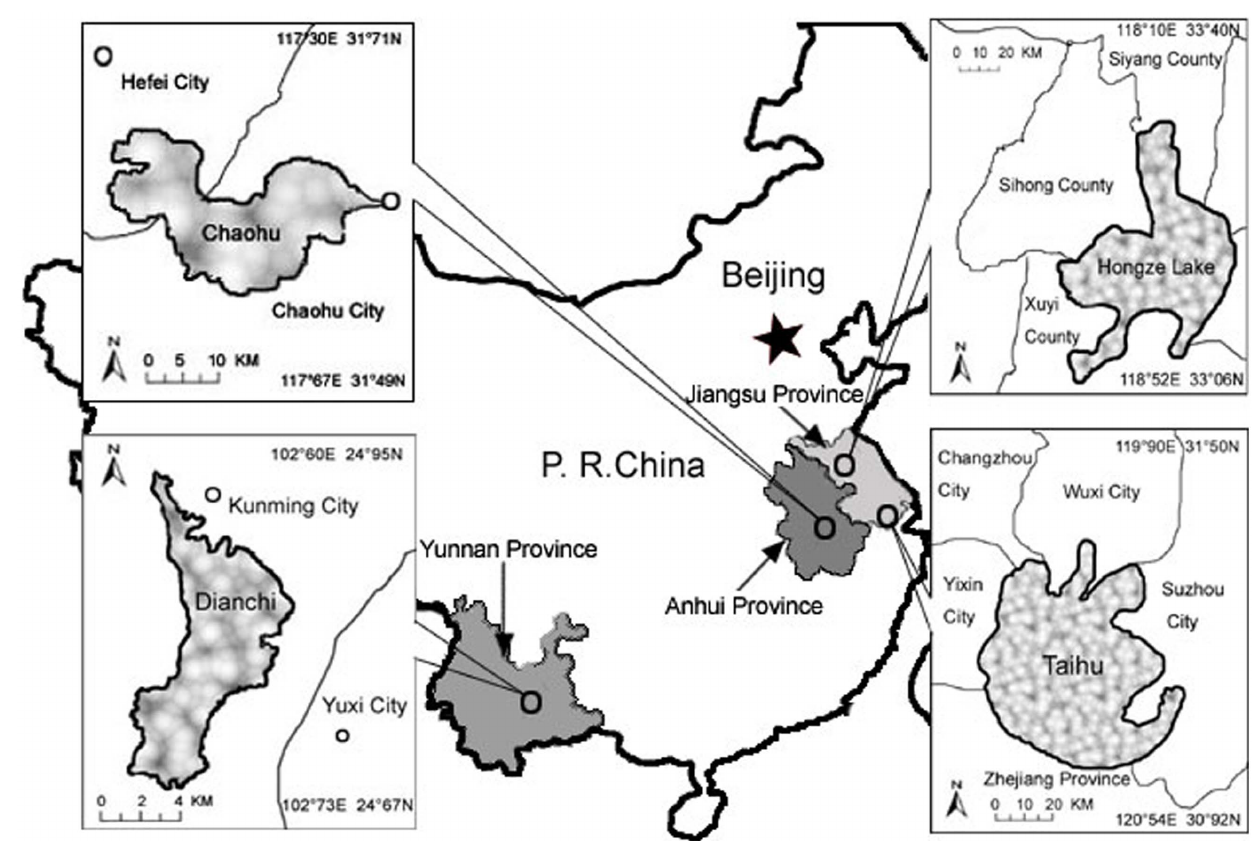
Figure 1. Location of investigating area and four large lakes in China.